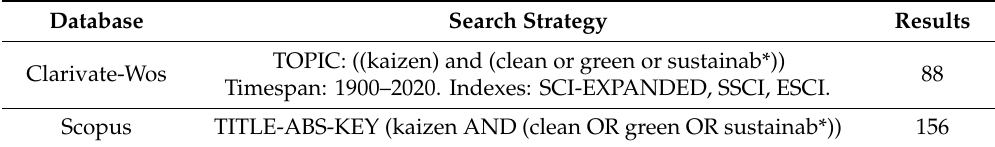
Table 3. Search strategies by author